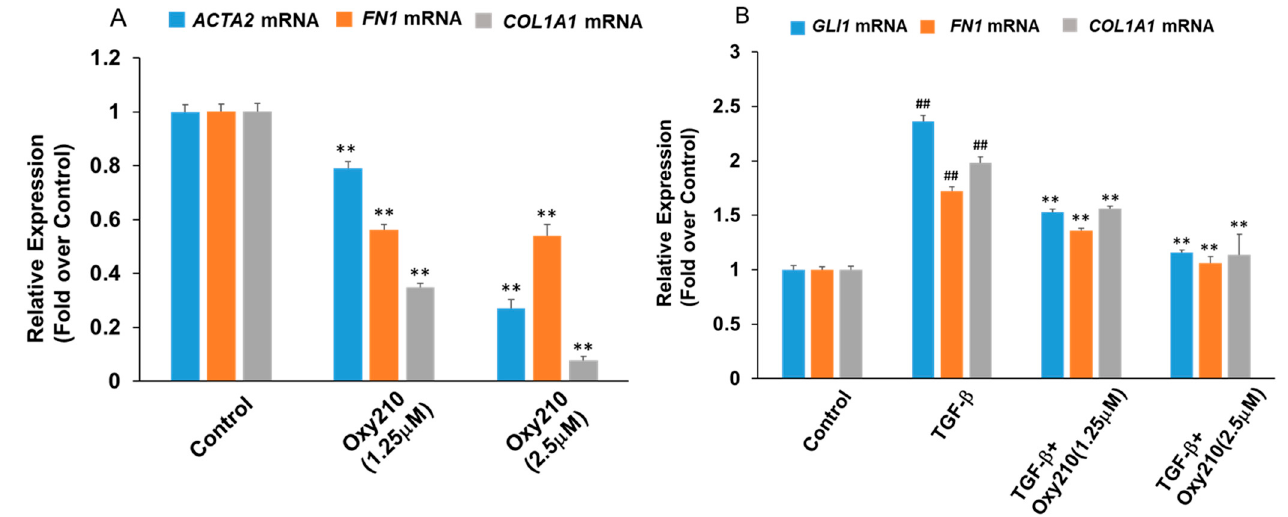
Figure 6. Inhibition of basal and TGF- β -induced expression of fibrotic genes in human renal fibroblast cells by Oxy210. ( A ) human renal fibroblast cells were treated with Oxy210 in DMEM containing 1% FBS for 48 h and then RNA was extracted and analyzed by Q-RT-PCR for the expression of the genes and normalized to GAPDH expression. Data from a representative experiment are reported as the mean of triplicate determinations ± SD (** p < 0.01 vs. control). ( B ) Human renal fibroblast cells were pretreated with Oxy210 in DMEM containing 1% FBS for 2 h and then treated with TGF- β 1 (10 ng/mL) in the absence or presence of Oxy210 for 48 h. RNA was extracted and analyzed by Q-RT-PCR for the expression of the genes and normalized to GAPDH expression. Data from a representative experiment are reported as the mean of triplicate determinations ± SD (## p < 0.01 vs. control; ** p < 0.01 vs. TGF- β ).